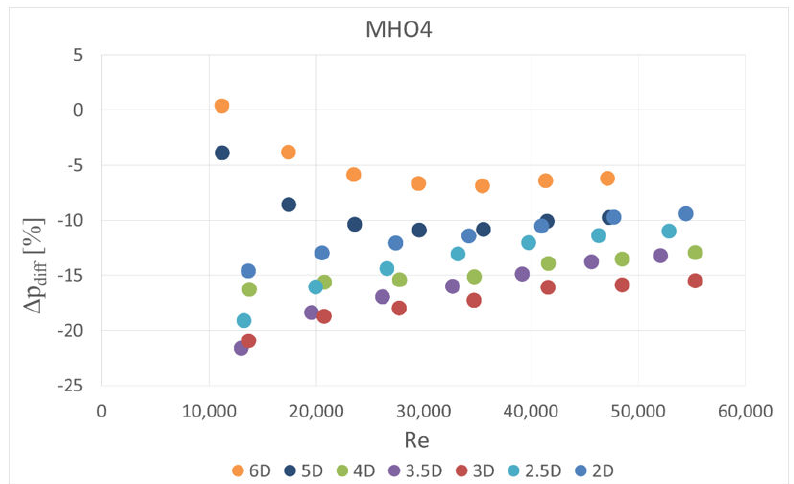
Figure 14. Pressure drop di ff erence for